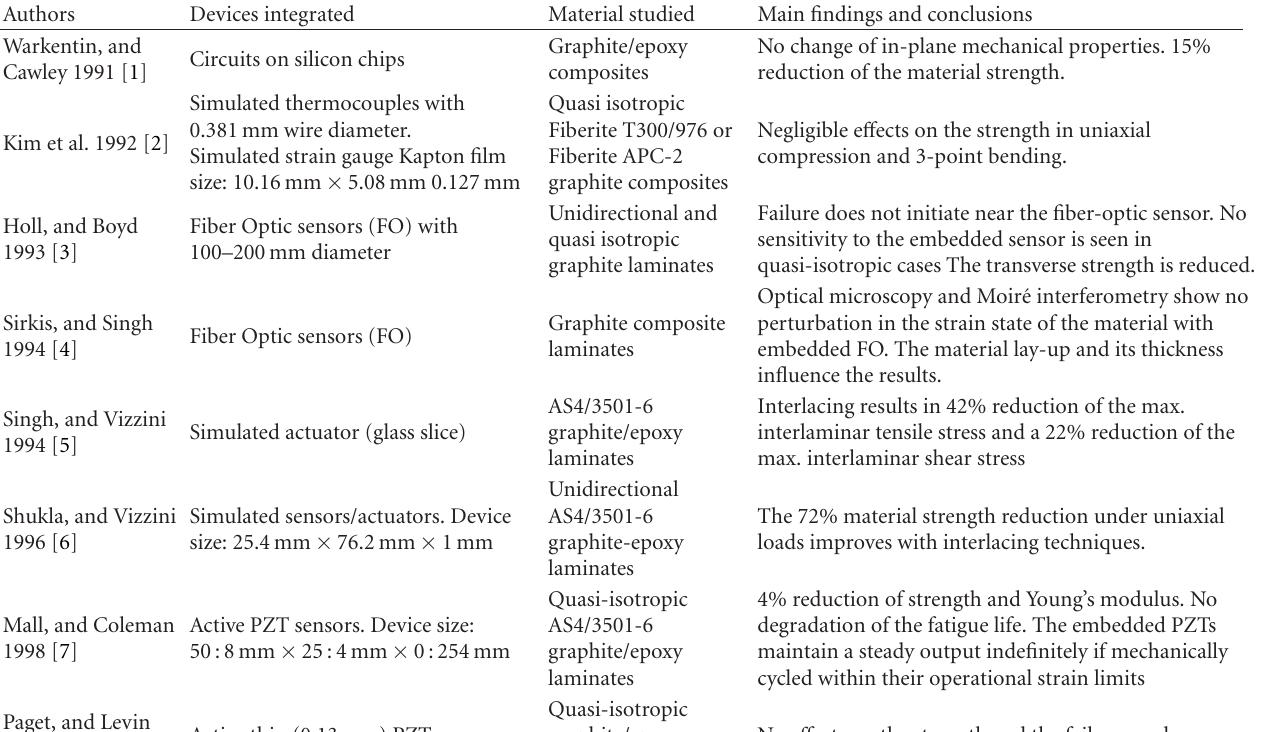
Table 1: List of some significant experimental contributions on the evaluation of the e ff ects of integrated devices on the structural integrity of composite